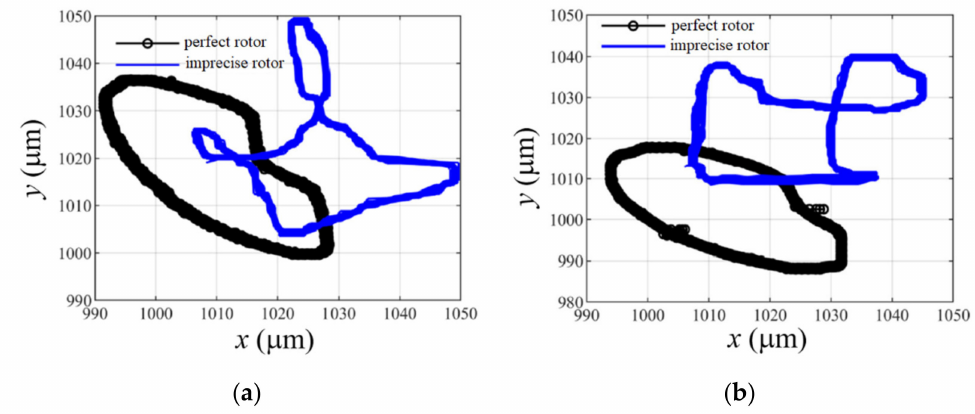
Figure 19. Whirling orbits for the perfect and imprecise rod–disk rotor before and after the first critical speed. ( a ) 2250 rpm; ( b ) 2850